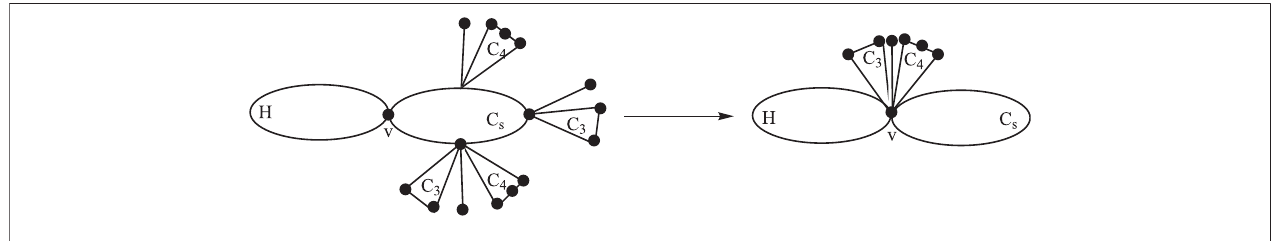
FIGURE 3 | Graphs G 1 and G 2 of Lemma